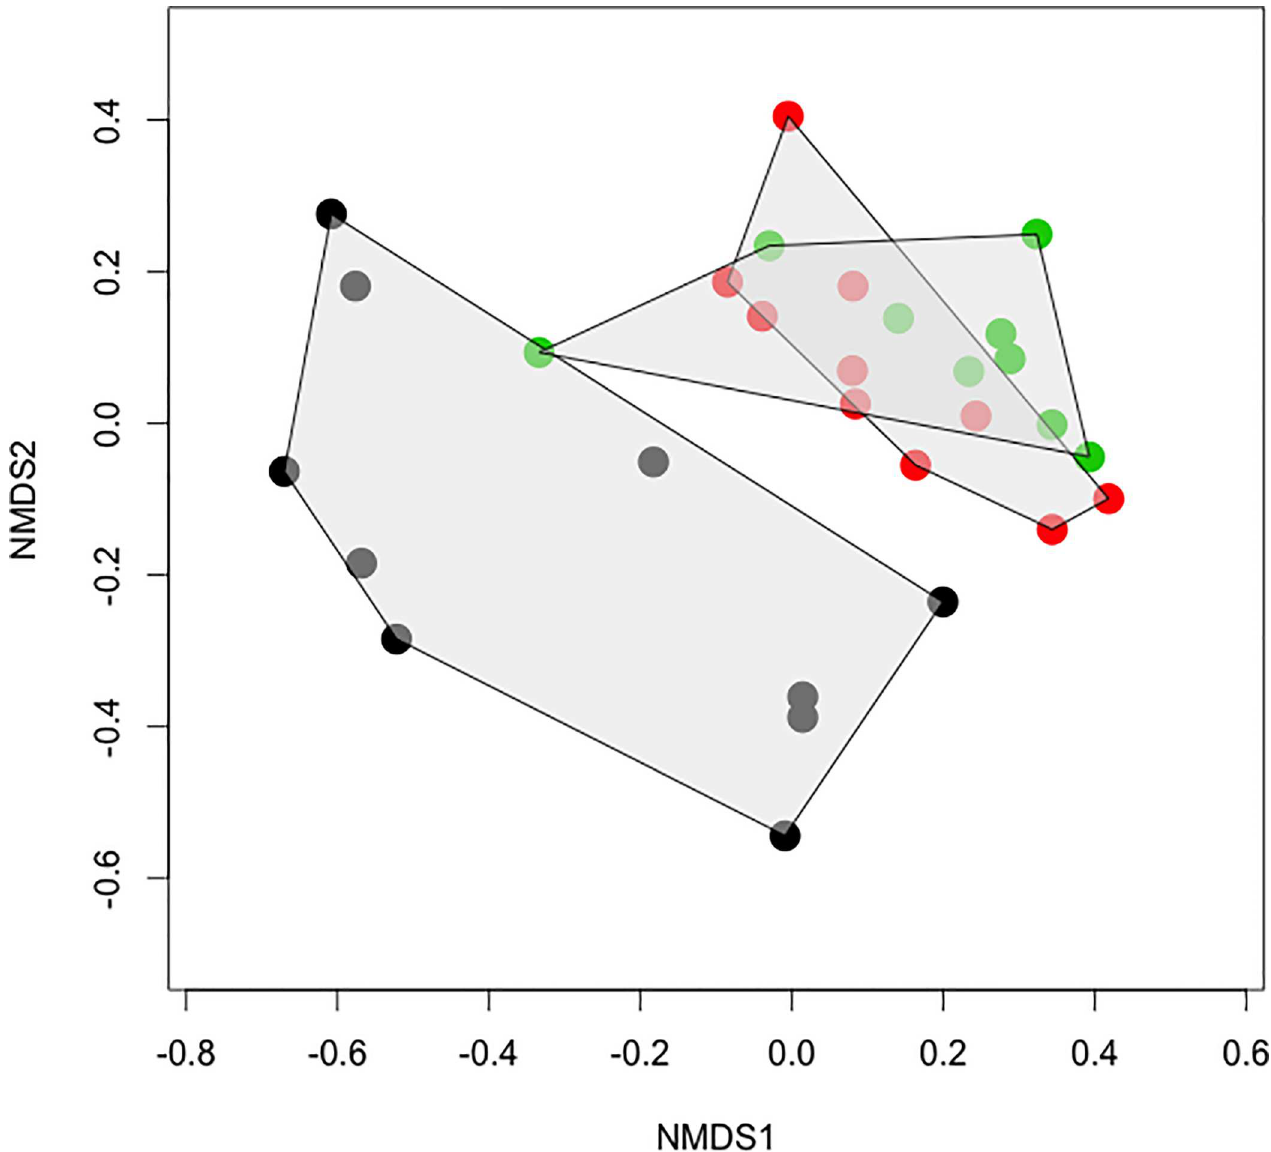
Fig 4. Host floral scent mimicry by Monilinia vaccinii-corymbosi ( Mvc ) shoot strikes. Non-metric multidimensional scaling (NMDS) plot of volatile profiles from Vacciniumcorymbosum flowers (red points), uninfected leaves (black), and leaves infected with Mvc (green). Total area occupiedby each sample type as represented in 2-dimensional space is shaded in gray. Stress = 0.134. VOC profiles differed significantly among the three tissues sampled (pMANOVA F 2,28 = 8.1, P = 0.009), with healthy leaves differing from flowers ( F 1,19 = 9.8, P = 0.009) and infected leaves ( F 1,18 = 9.3, P = 0.010), while flowers vs. infected leaves were marginally, but not significantly different ( F 1,18 = 3.0, P = 0.083).